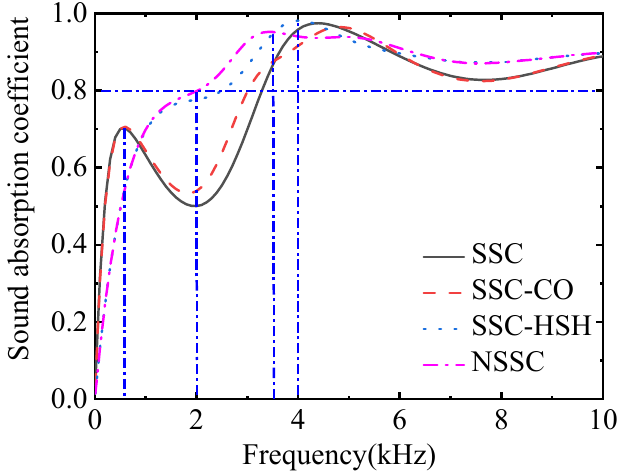
Figure 6. Comparison of α of SSC, SSC-CO, SSC-HSH, and NSSC.